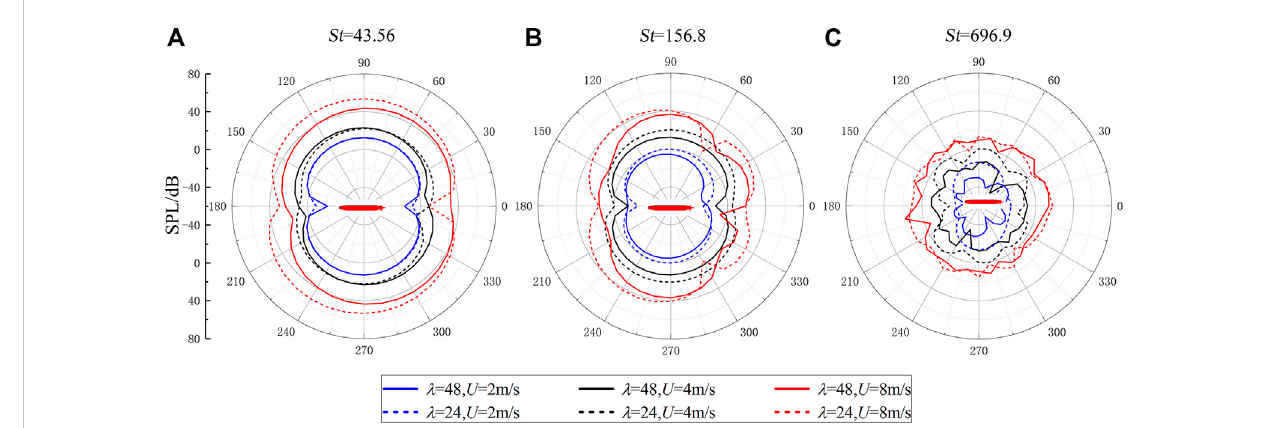
the dipole source.